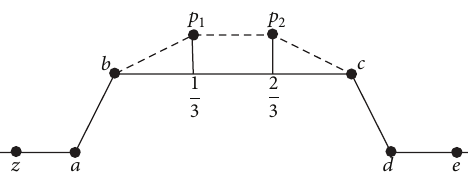
Figure 1: Labeling a sample control polygon. The newly inserted points between old vertices 𝑏 and 𝑐 are referred to as 𝑝 1 , 𝑝 2 , ... , 𝑝 𝑛−1 , respectively.